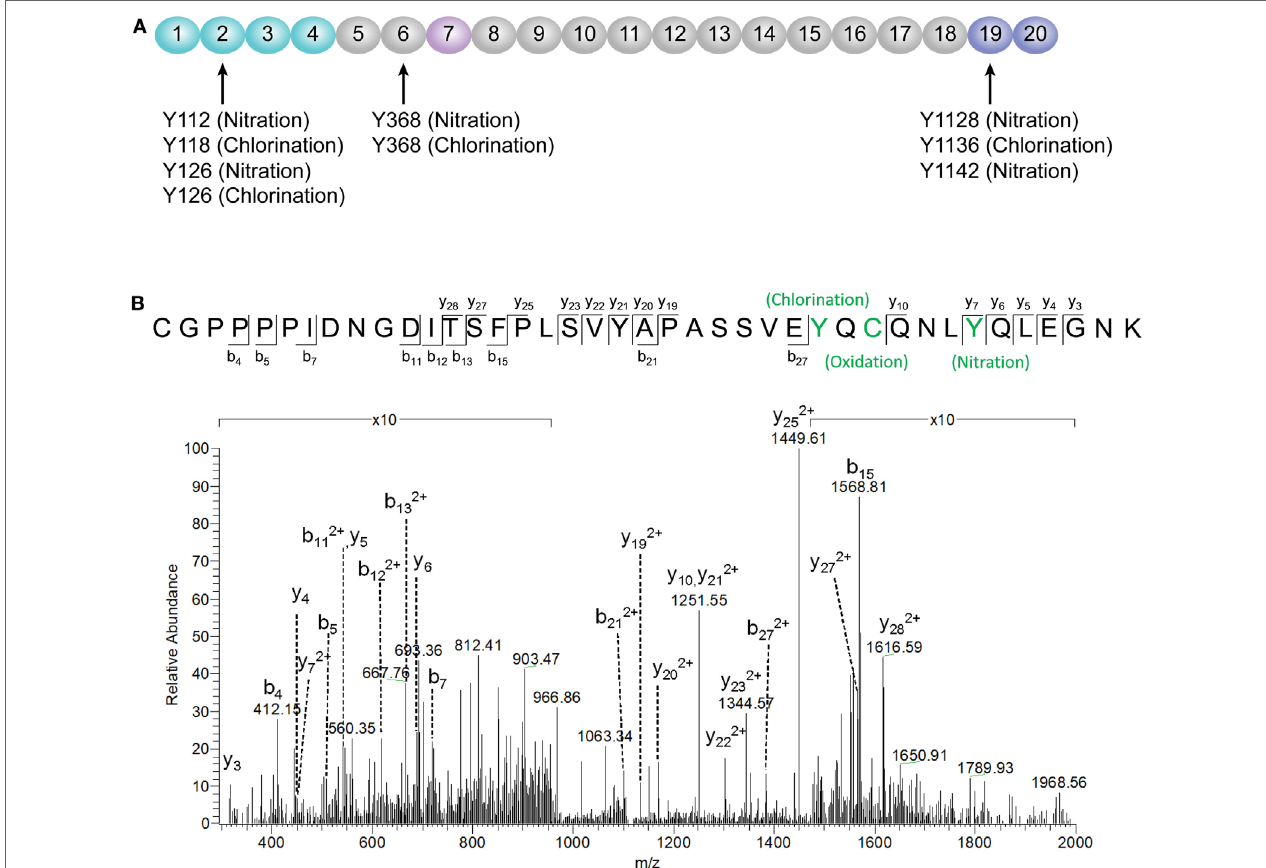
FigUre 6 | Identification of factor H (FH) modifications by mass spectrometry analysis. (a) Summary of all tyrosine nitration and chlorination sites of FH identified in patients with active ANCA-associated vasculitis. The position of the nitrated/chlorinated tyrosine is determined based on the theoretical nitrated/chlorinated peptide tandem mass spectrum with the highest Mascot score. The amino acid sequence of FH is referred to the UniProt database. (B) A representative mass spectrogram showing the detection of chlorination of Y1136 and nitration of Y1142 located at SCR19 of FH.